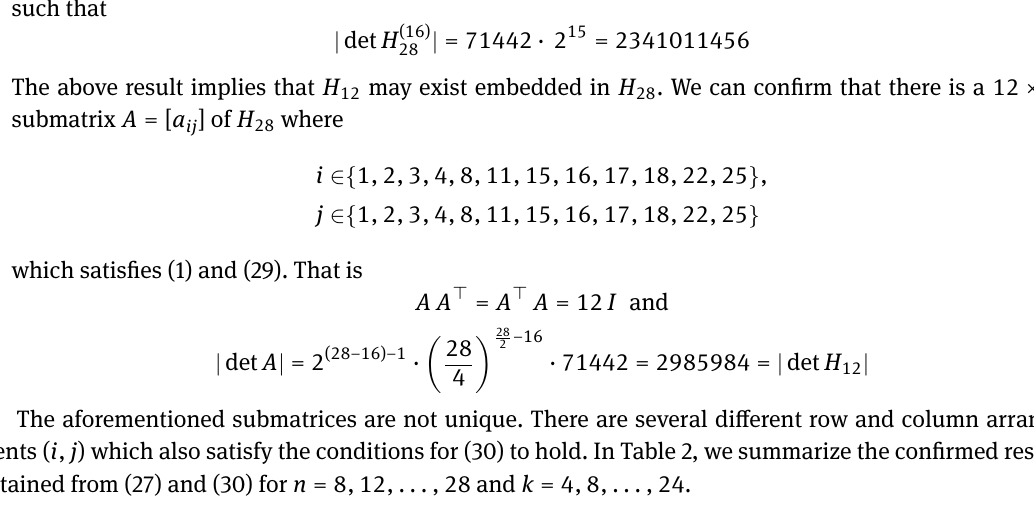
Order k = 4 k = 8 k = 12 k = 16 k = 20 k = 24 n = 8 H 4 ∈ H 8 n = 12 H 8 / ∈ H 12 H 4 ∈ H 12 n = 16 H 12 / ∈ H 16 H 8 ∈ H